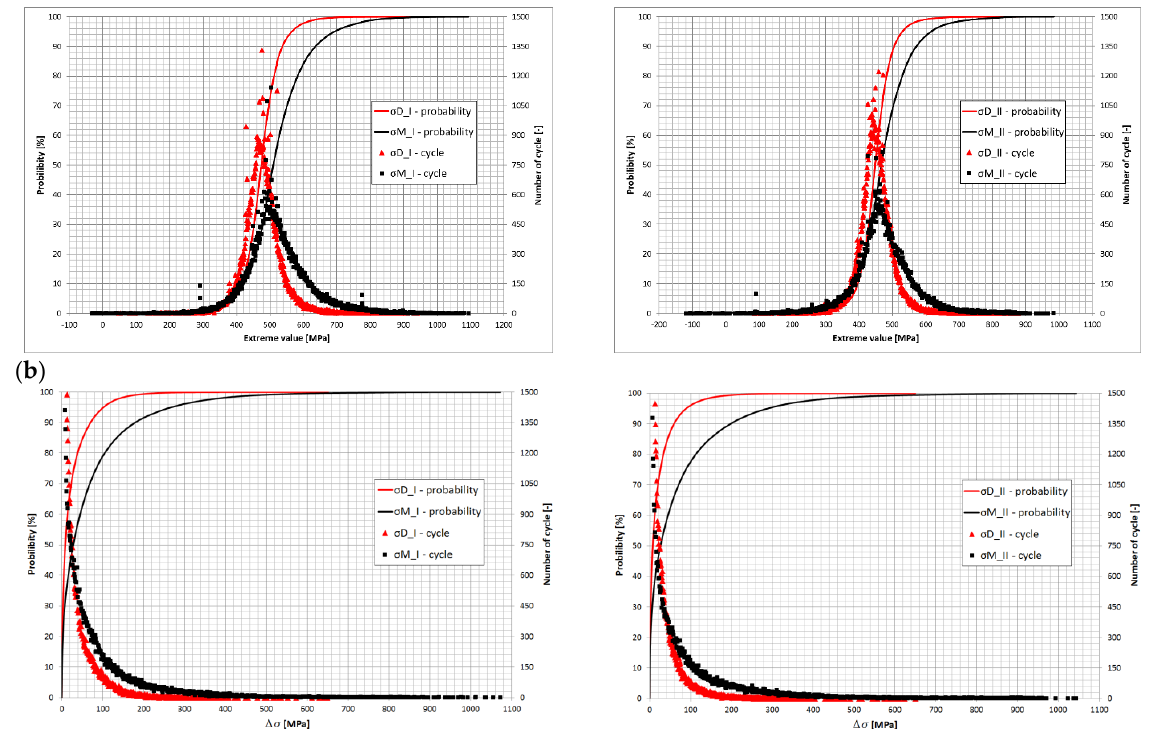
Figure 8. Symmetric and asymmetric stress distributions of both axle springs and the corresponding numbers of cycles of ( a ) alternating stress ( b ) stress ranges.